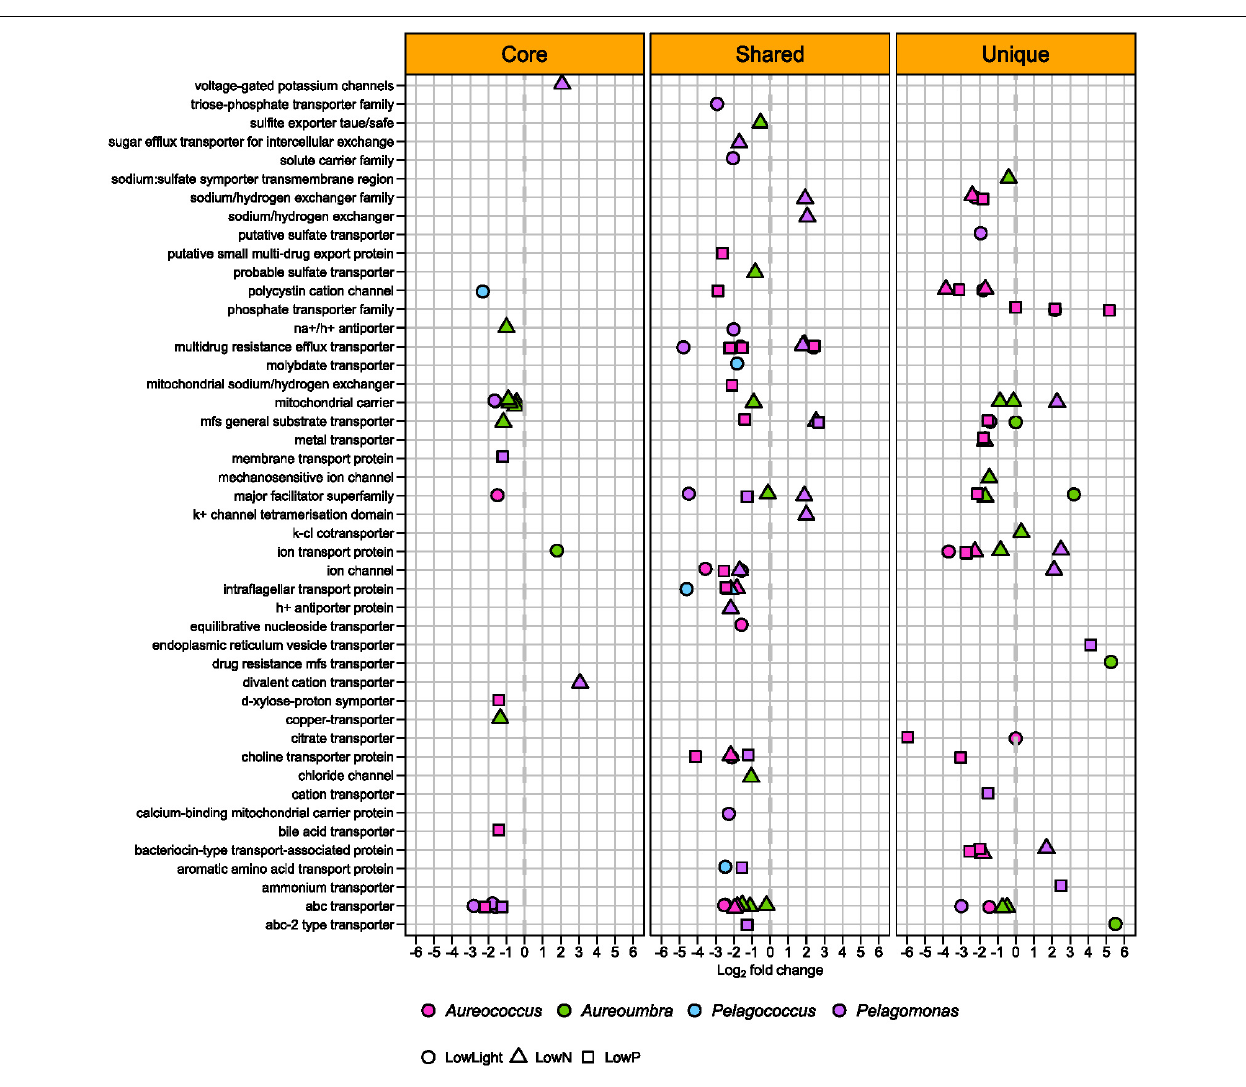
Frontiers in Marine Science |